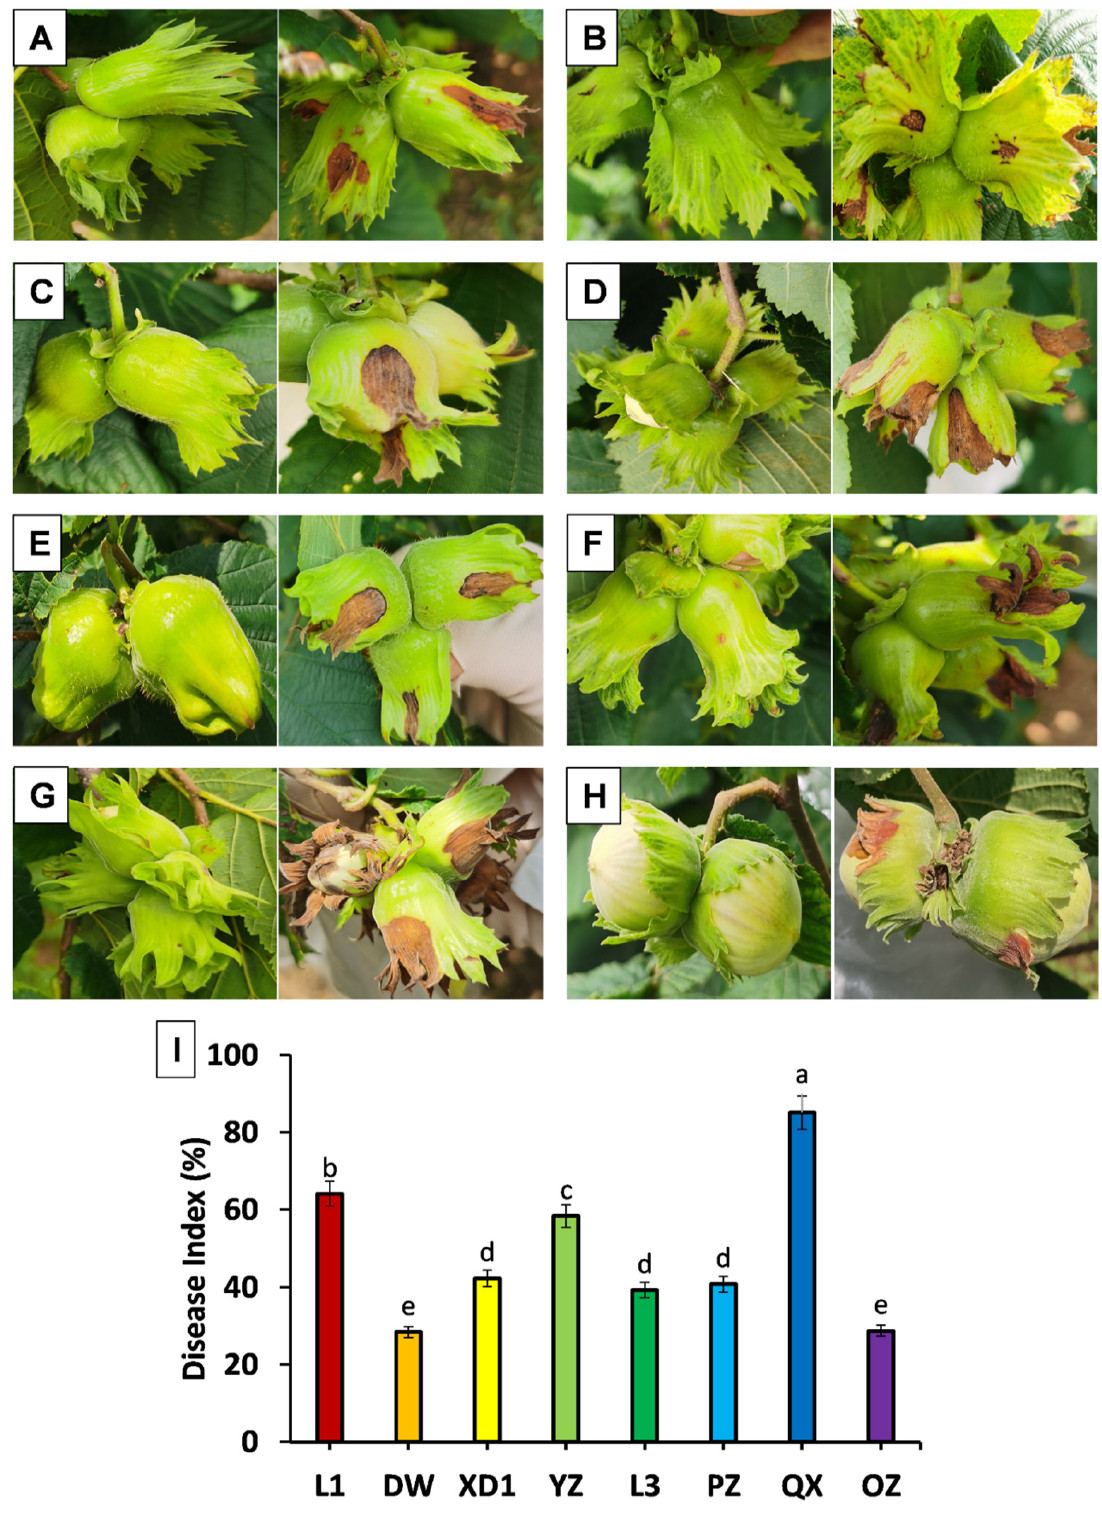
Figure 1. Disease symptoms in hazelnut tree infected with B. cinerea . ( A ) Liao 1 (L1) ( B ) Dawei (DW), ( C ) Xianda No. 1 (XD1), ( D ) Yuzhui (YZ), ( E ) Liao 3 (L3), ( F ) Ping hazelnut (PZ), ( G ) Qiuxiang (QX), ( H ) European hazelnut (OZ). ( I ) Disease index (%) recorded 3 days after inoculation of B. cinerea in hazelnut varieties. The figure on the left of panel ( A – H ) indicates control plants (CK) and the figure on the right side of panel ( A – H ) showed plants infected by B. cinerea . Different letters above bars indicate significant difference at p ≤ 0.05.